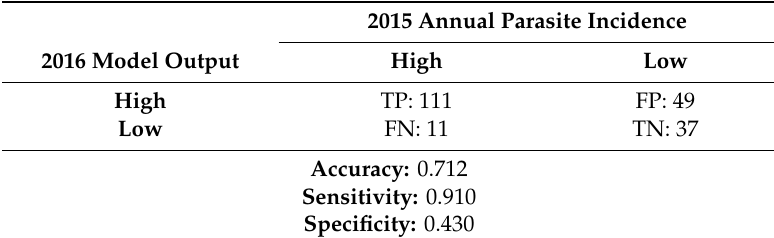
Figure 5. Receiver operating characteristic (ROC) curve of the malaria risk model. Blue line and black diagonal line represent the ROC of the model and the random ROC, respectively. Table 6. Results of ROC analysis.